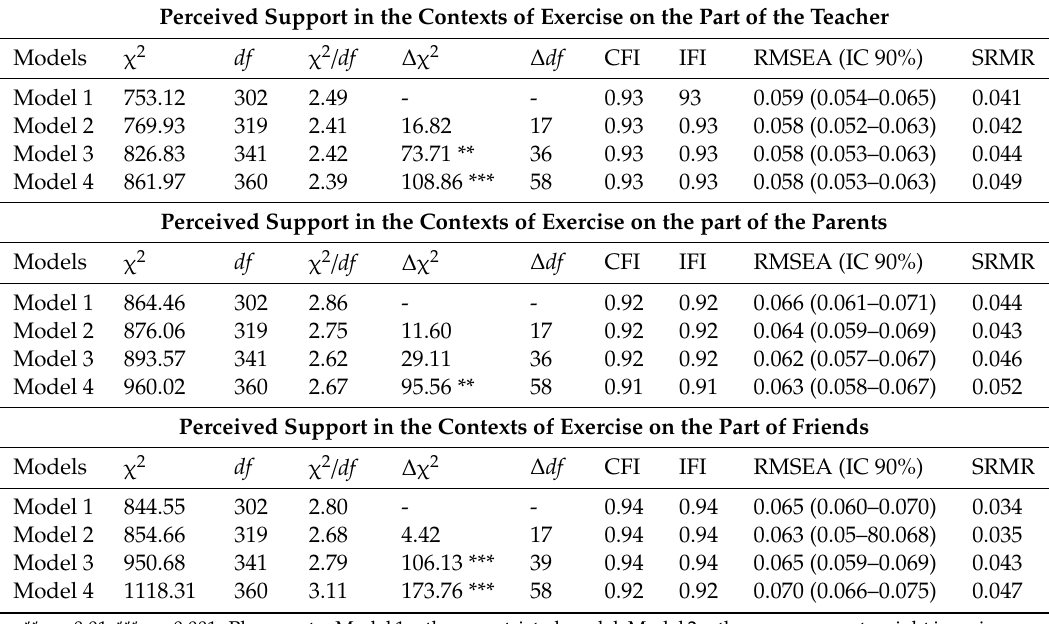
Table 2. Gender Invariance Analysis.